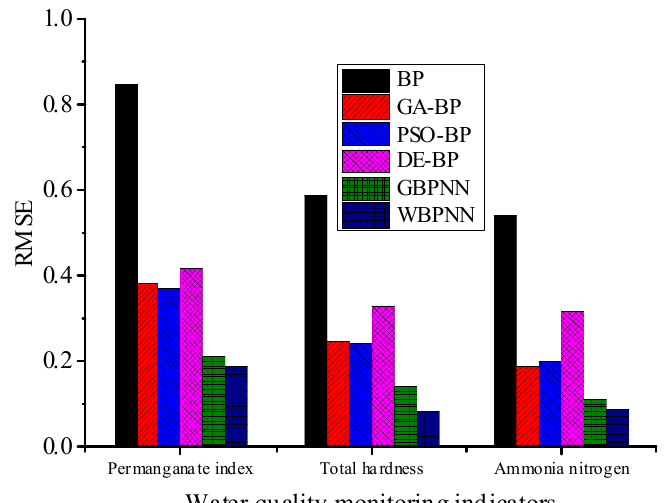
Figure 7. Statistic results of water prediction based on the RMSE.